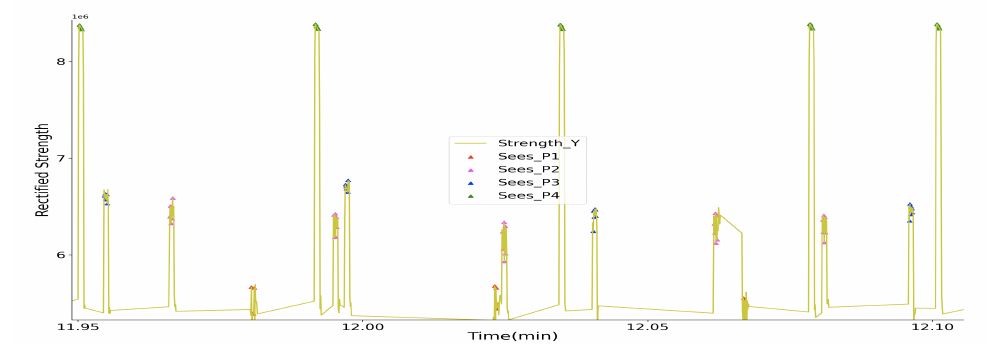
Figure 24. A close look of the asynchronous protocol, where each transmitter being activated after a random length of time window, and the receiver firstly listens for an identifier, then samples the strength after an identifier is